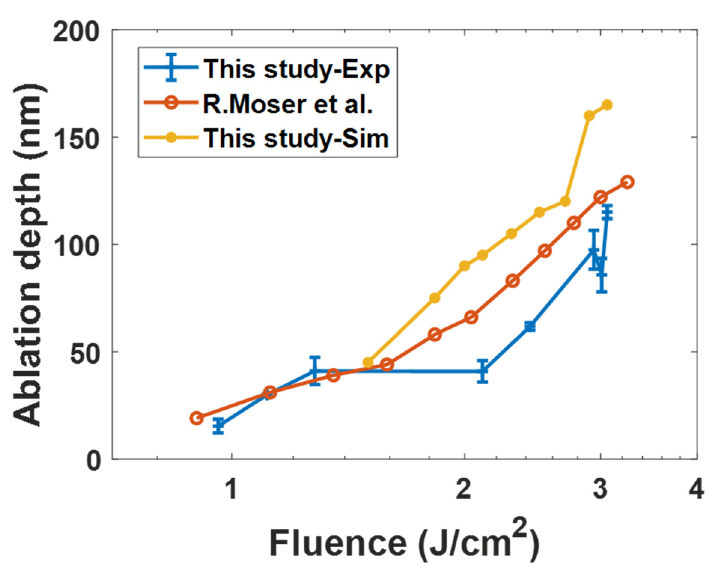
Figure 9. Comparison of the simulation and experimental ablation depths. The ablation data of red line was purposed by [24].